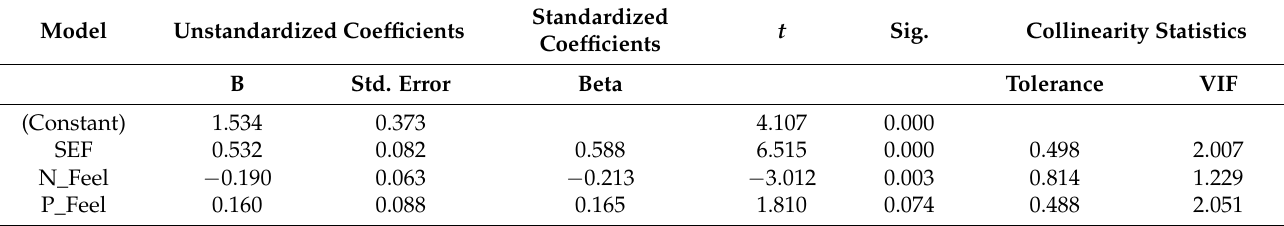
Table 3. Initial multicollinearity